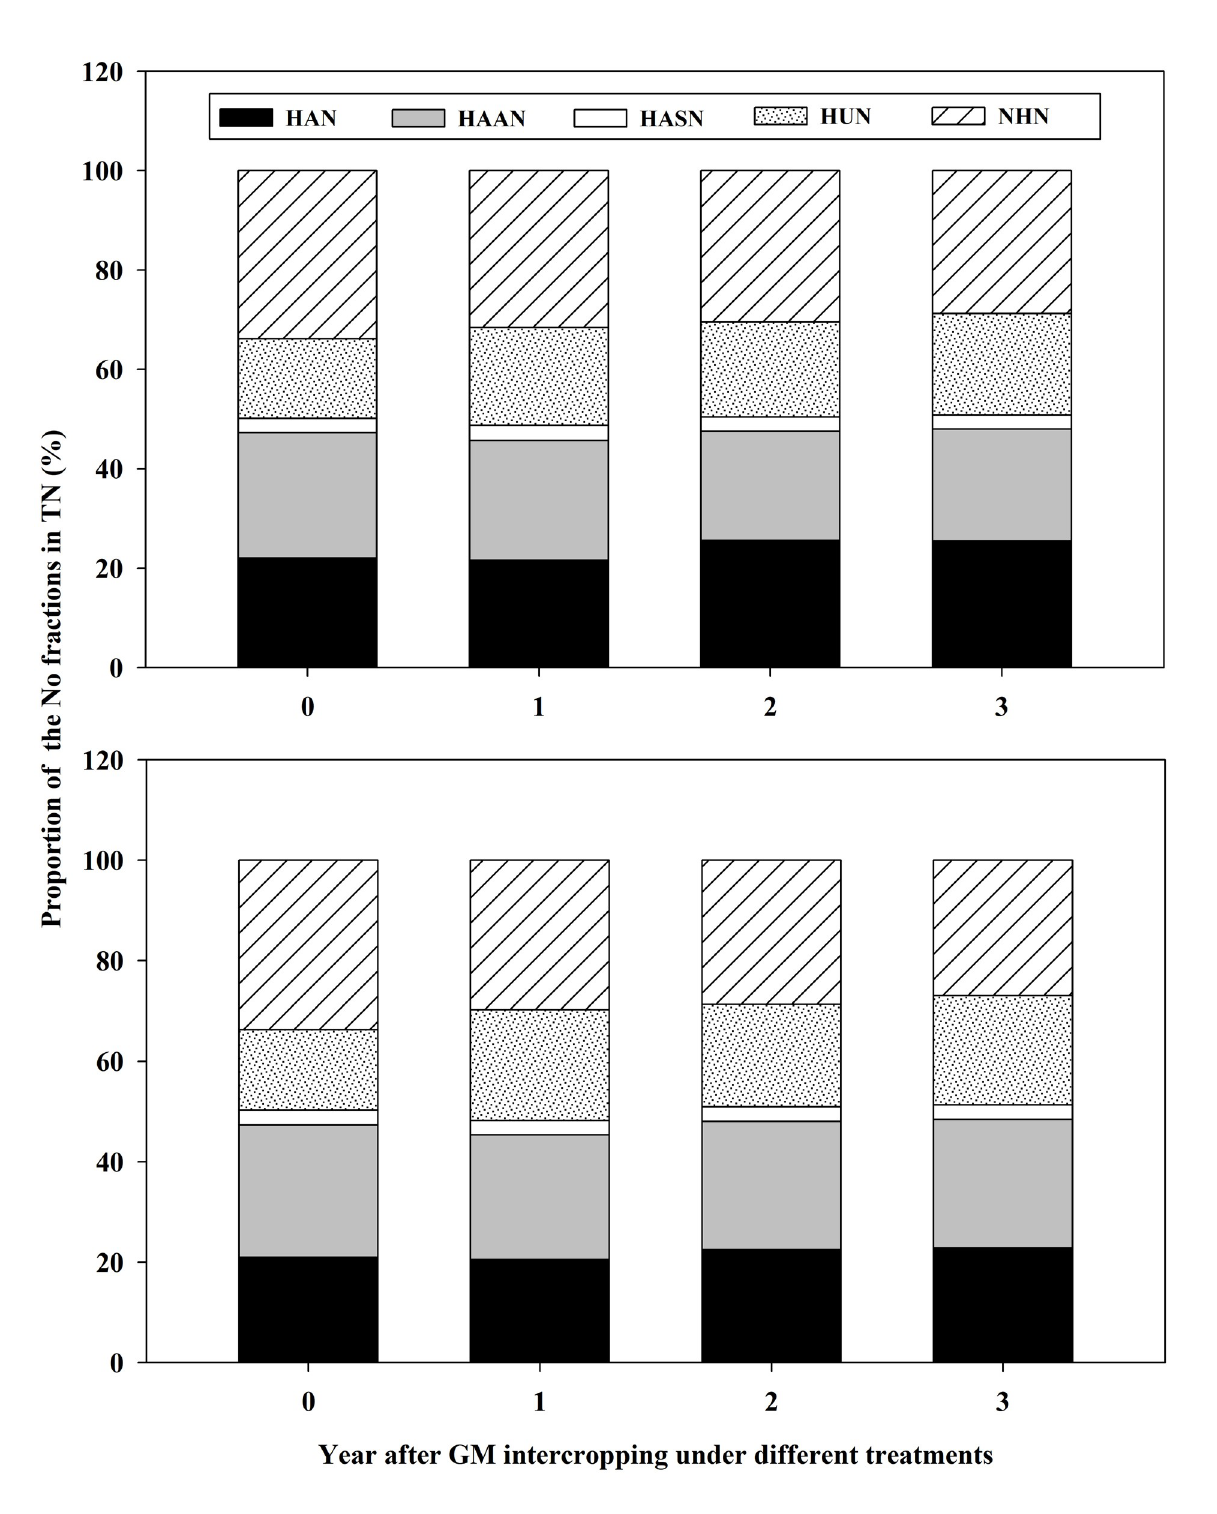
Fig 2. Proportion of organic nitrogen to total nitrogen for each soil fraction. The left figure is the MUP treatment: intercropped GM was mulched around the coconut trees after the GM was cut; The right figure is the GMUP treatment: intercropped GM was buried in a fertilization pit after the GM was